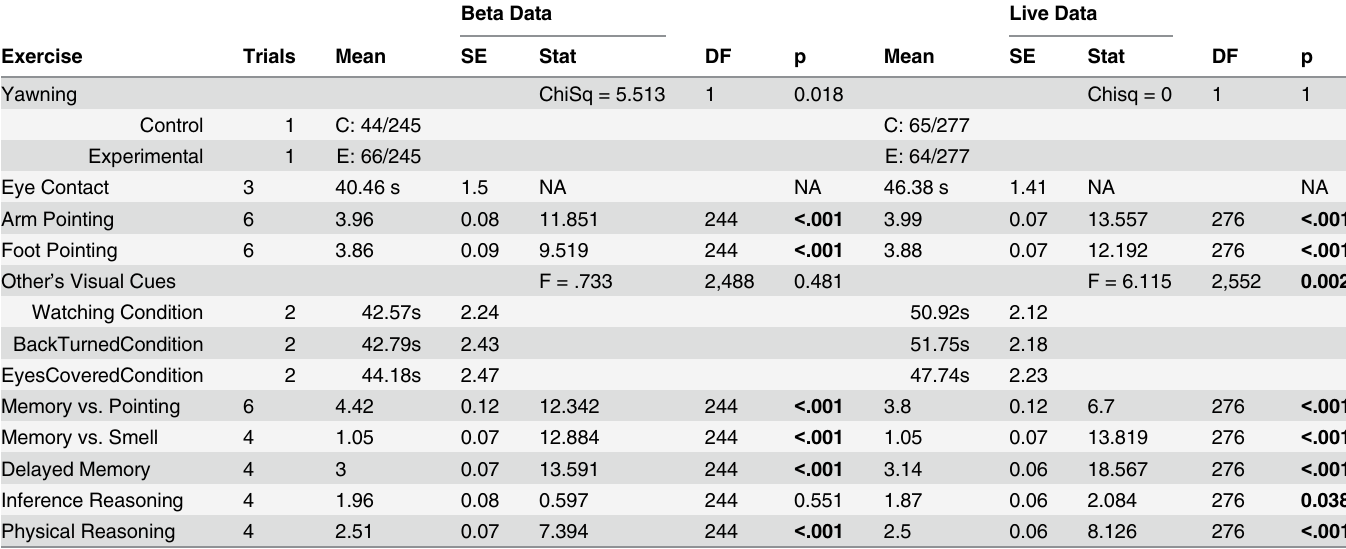
Table 4. Descriptive and test statistics comparing experimental (E) and control conditions (C) in each task of the Beta (N = 245) and Live (N = 277) datasets. All tests were One-Sample T-tests except visual cues tasks (Repeated ANOVA) and Yawning (McNemar ’